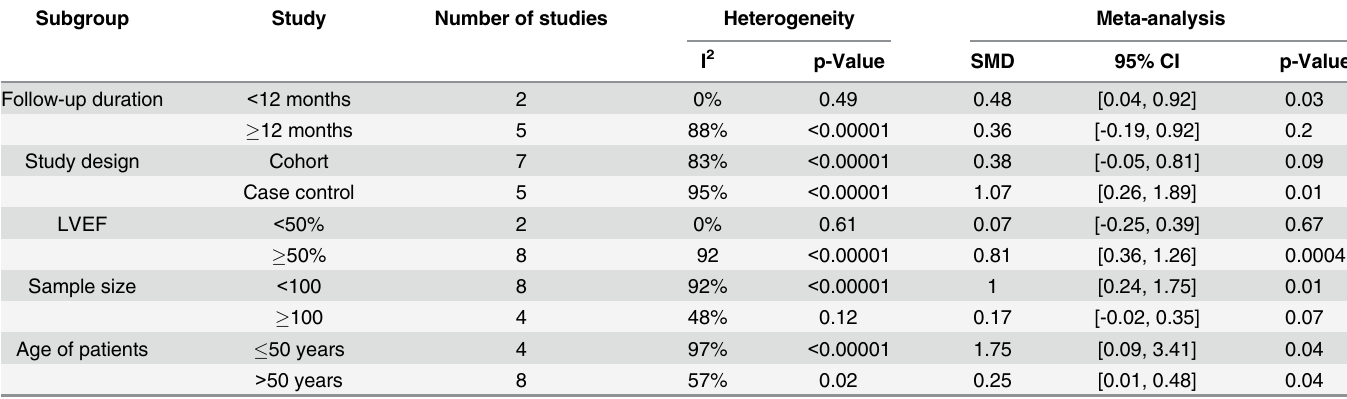
AF = atrial fi brillation; LVEF = left ventricular ejection fraction; CI = con fi dence interval; SMD = standard mean difference.